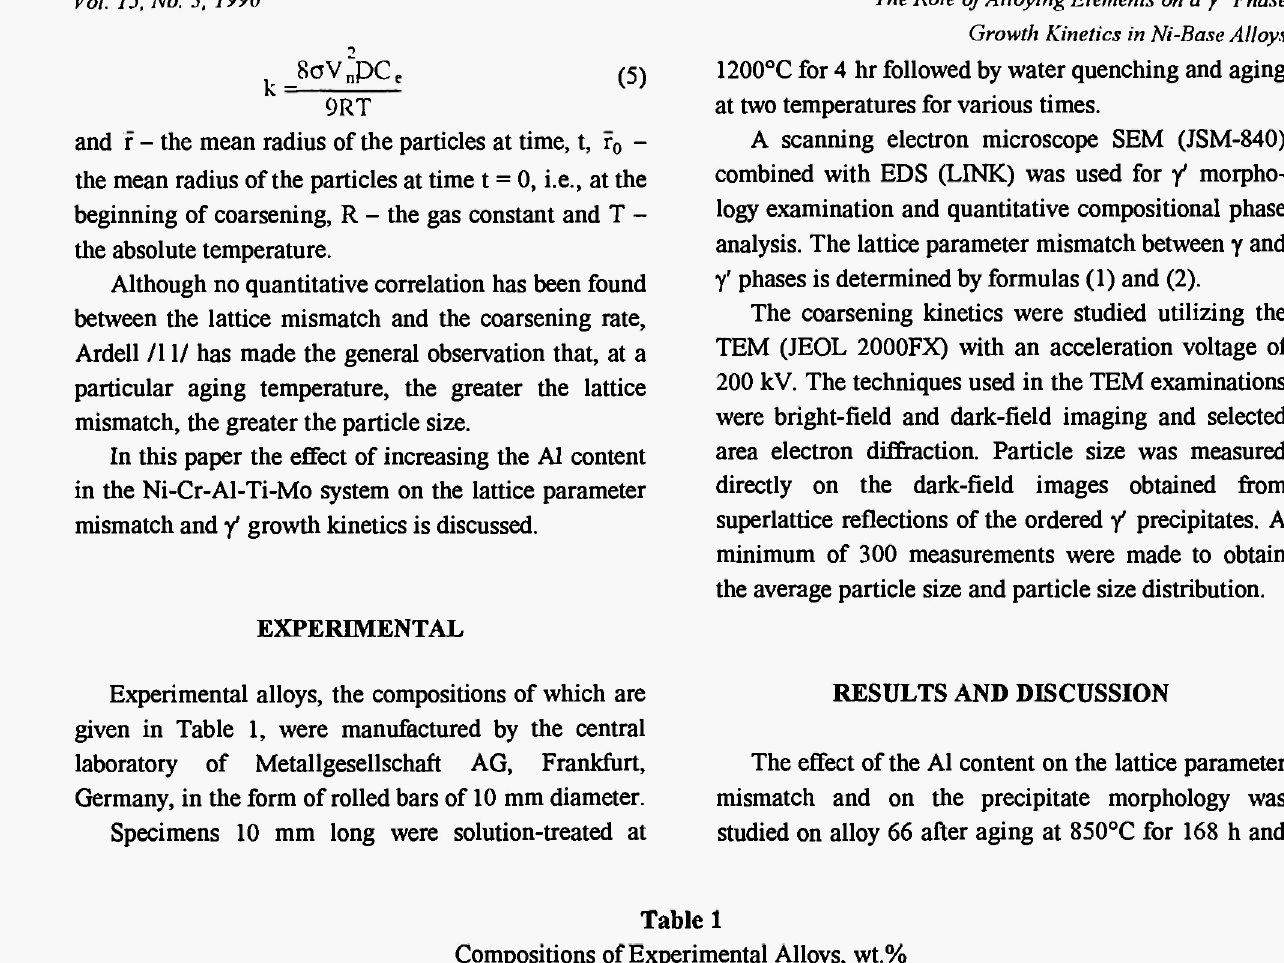
Compositions of Experimental Alloys,